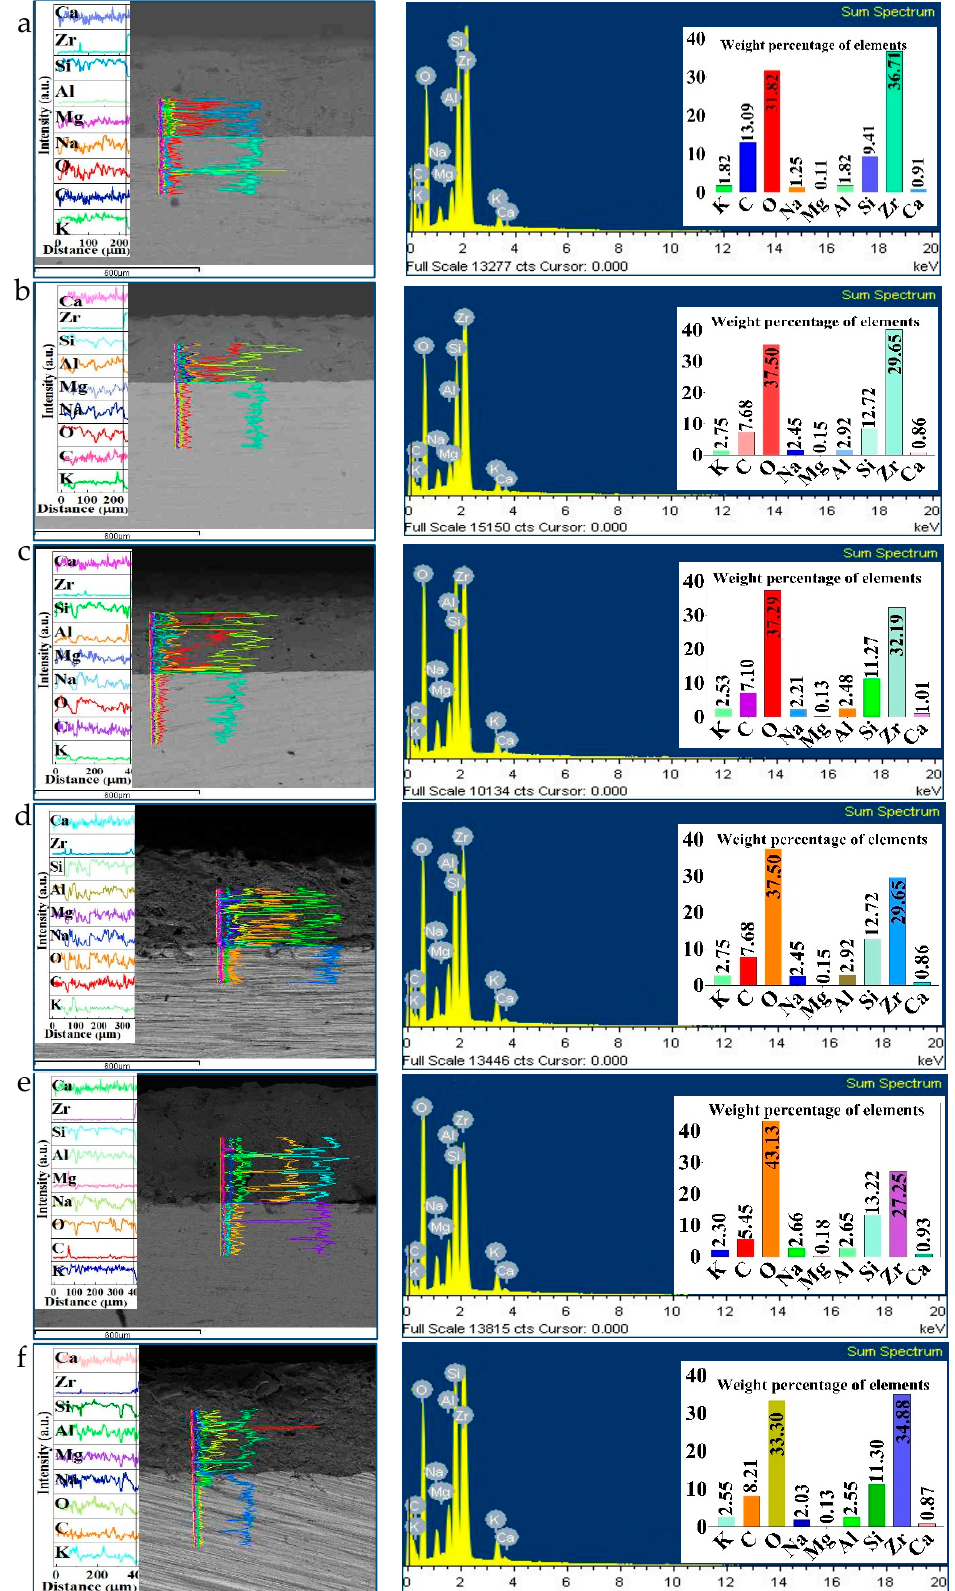
Figure 9. Line EDS analyses showing the elemental composition at the interfaces following different techniques: milling ( a ); grinding ( b ); sandblasting ( c ); L3 ( d ); L4 ( e ); and L5 ( f ), respectively.